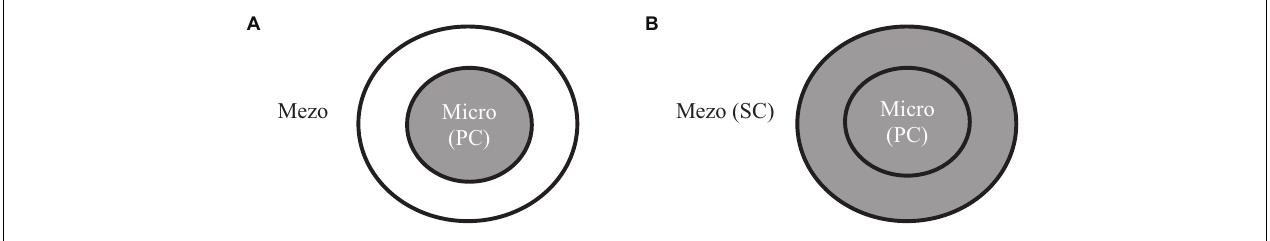
FIGURE 5 | Cultural orientations and coping in the context of pandemic (A) Individualism and (B) Collectivism. PC, primary control; SC, secondary control.